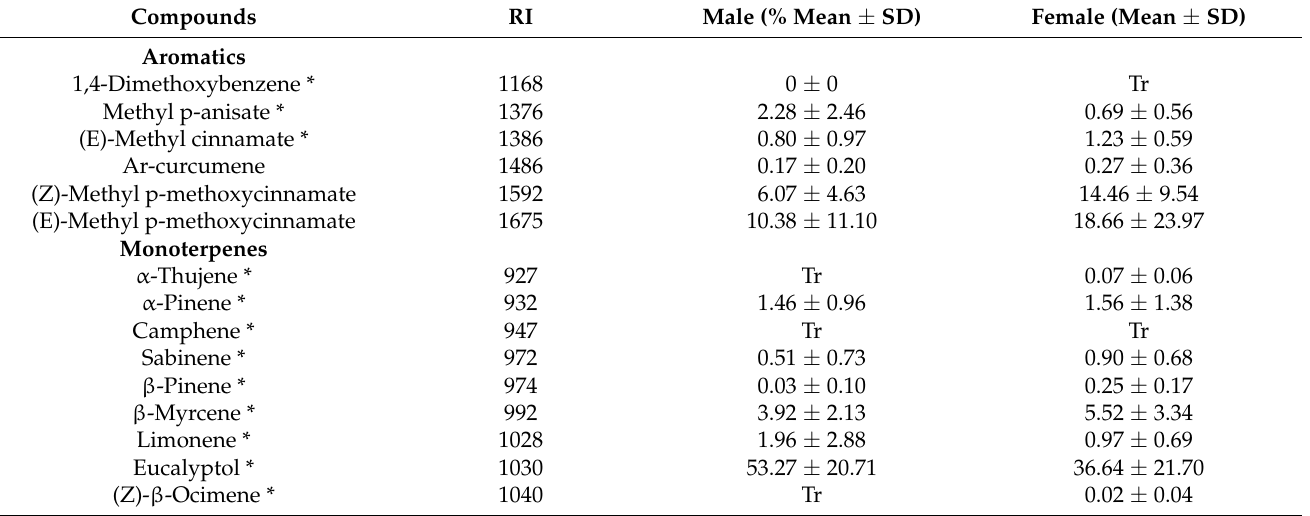
Table 1. Relative contribution of volatile compounds in headspace samples of male (n = 8) and female (n = 5) flowers of C. maranhense . Volatiles are grouped in compound classes and listed according to elution on an HP-5 column. RI: retention index. * Identification based on authentic standards. Chemical compounds with mean of emission rate < 0.01% and > 0% are considered a trace amount and identified as